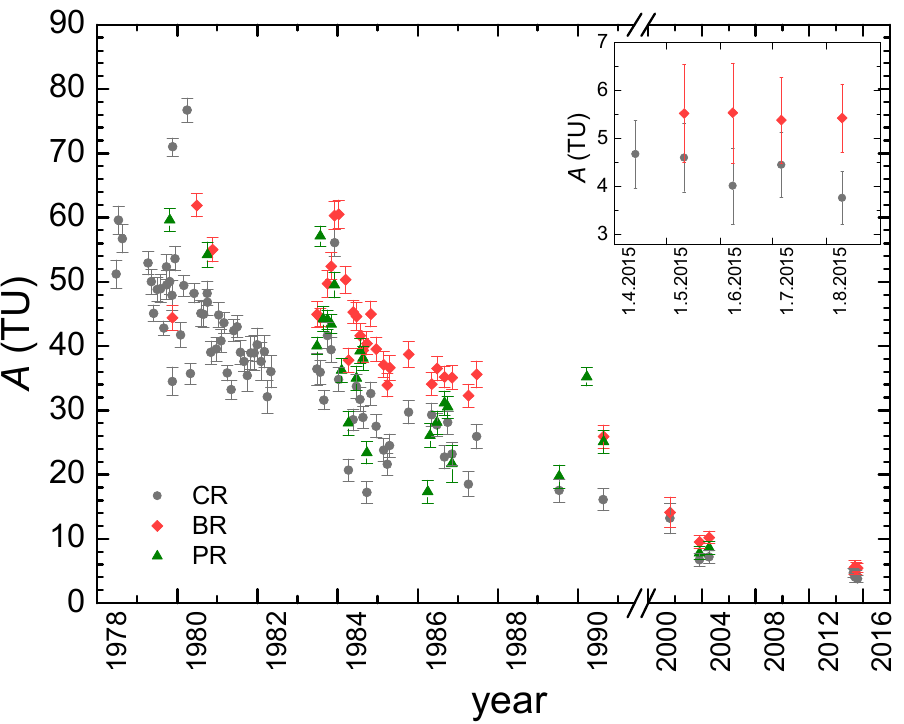
Figure 8. Tritium activity concentration in groundwater (CR, BR, and PR springs), 1978–2016. Data for the CR and BR springs in the spring–summer of 2015 are shown in the insert.